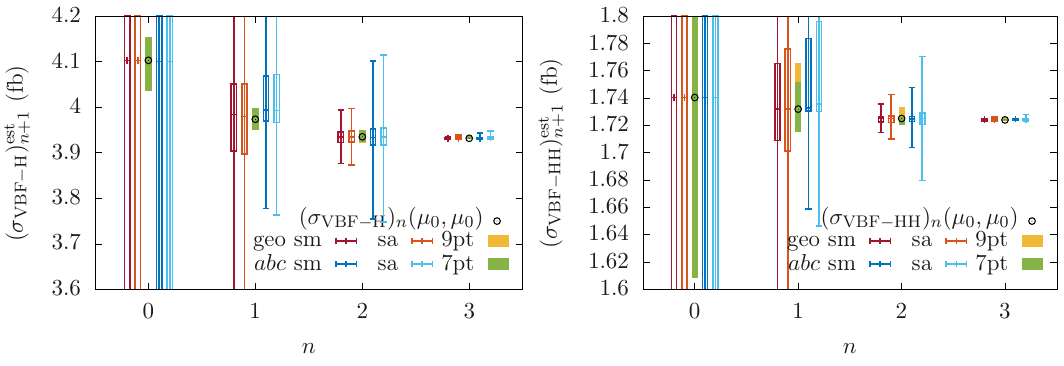
Figure 16 . The 68% and 95% CIs for the VBF cross-sections for Higgs and di-Higgs production for the geometric and abc -models using the sa- and sm-prescriptions. The scale variation intervals using 7 and 9 points are shown for